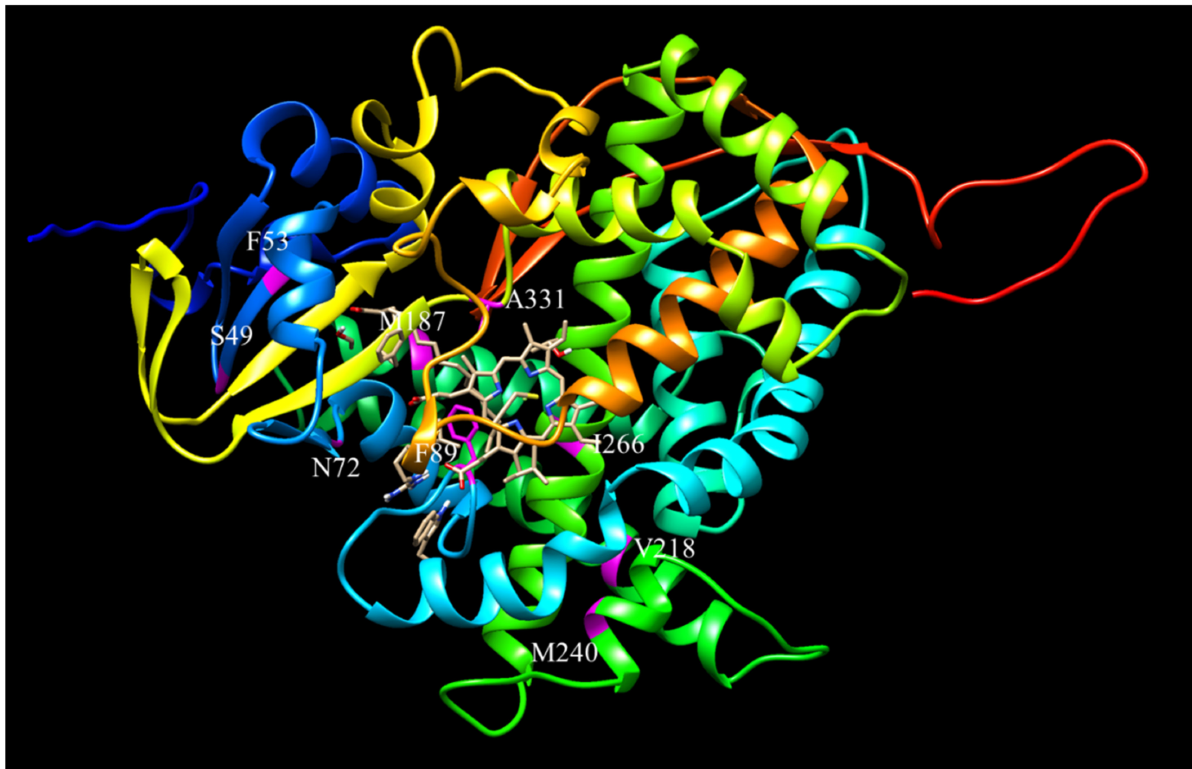
Figure 3. Homology model of BAMF2522 shown as ribbon diagram (based on structure of BM3 as the template, PDB ID: 1FAG, Chain A). Mutation sites chosen in this study for the engineering of BAMF2522 are shown in magenta. Heme porphyrin is shown in light brown and blue sticks. Representation of the corresponding mutation sites on the crystal structure of BM3 is given in the Supplementary Material (Figure S4).